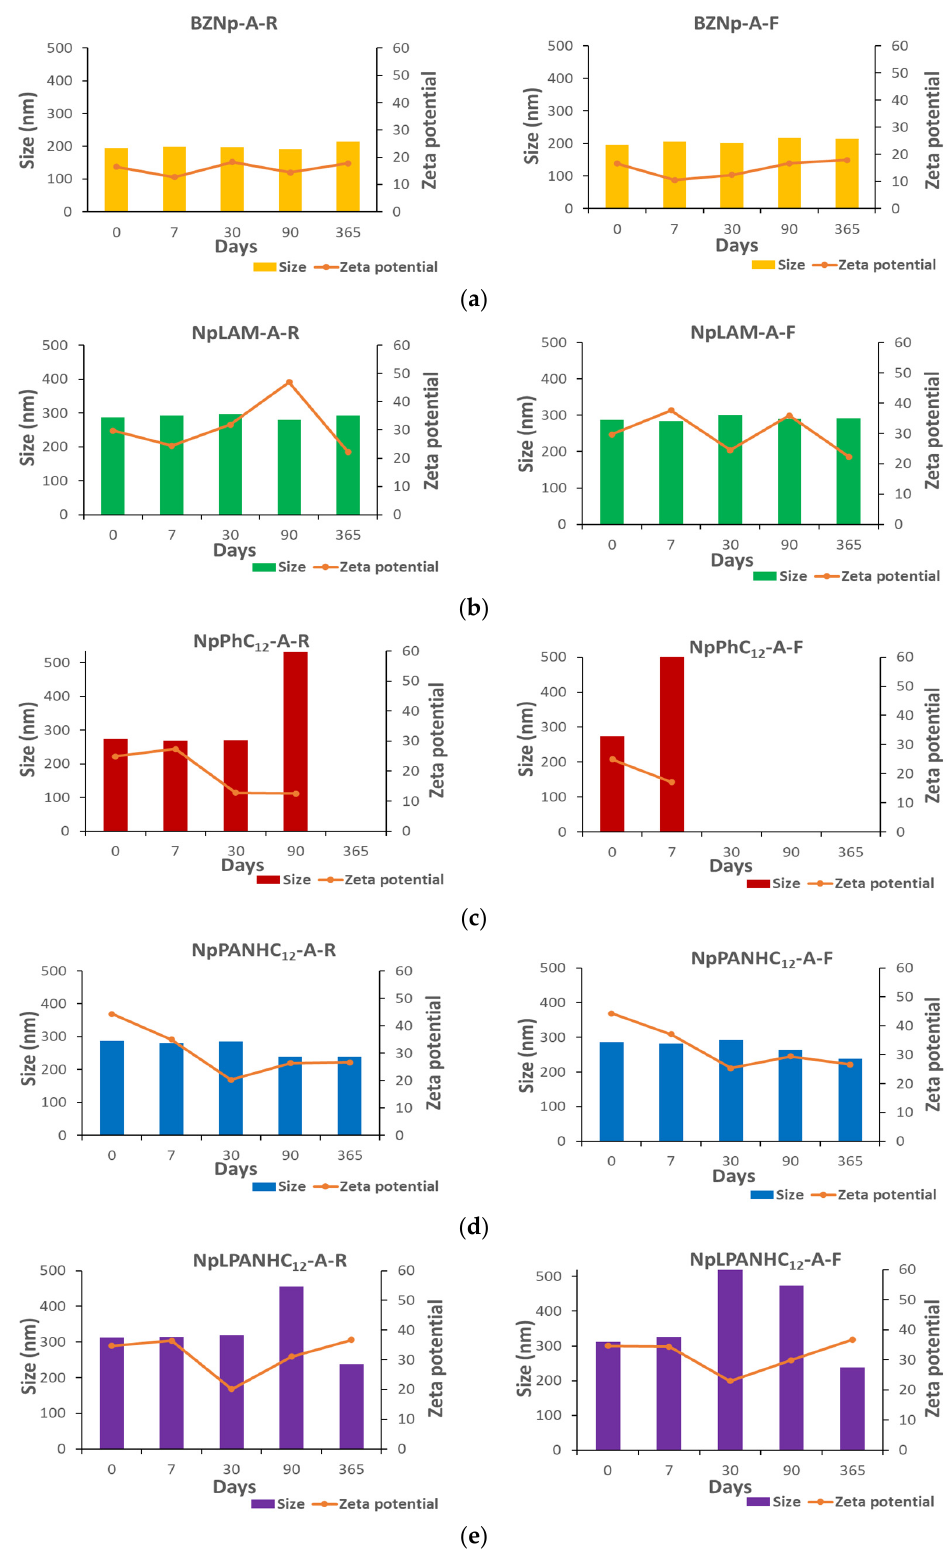
Figure 3. Size (nm) and zeta potential (mV) of: ( a ) blank, ( b ) LAM, ( c ) PNHC 12 , ( d ) PANHC 12 and( e ) C 12 PAM loaded-zein nanoparticles prepared by Method A and stored at room temperature (R) and freezer (F) over 365 days.